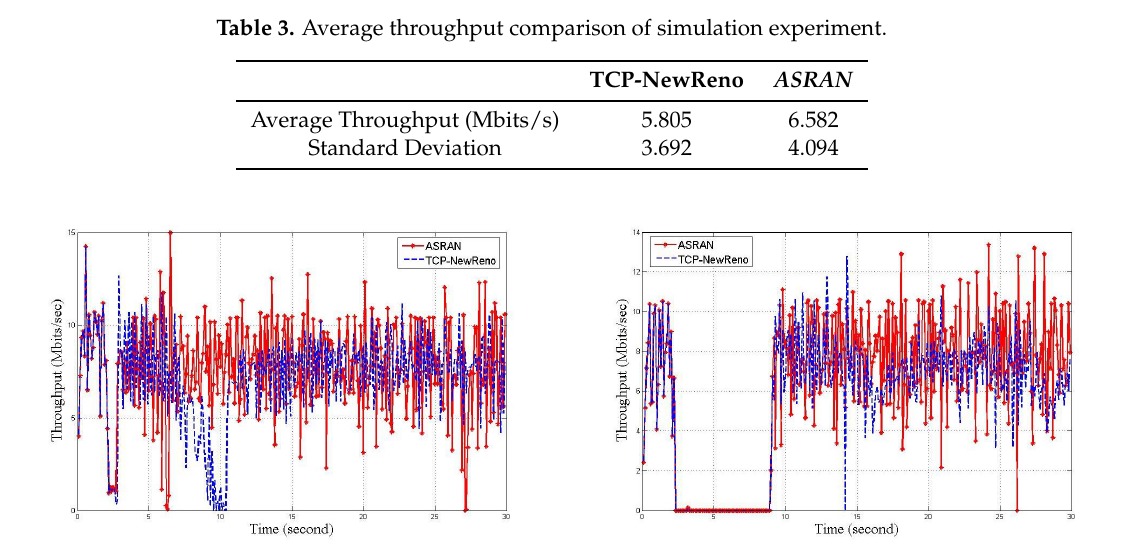
Figure 8. Throughput fluctuation of simulation